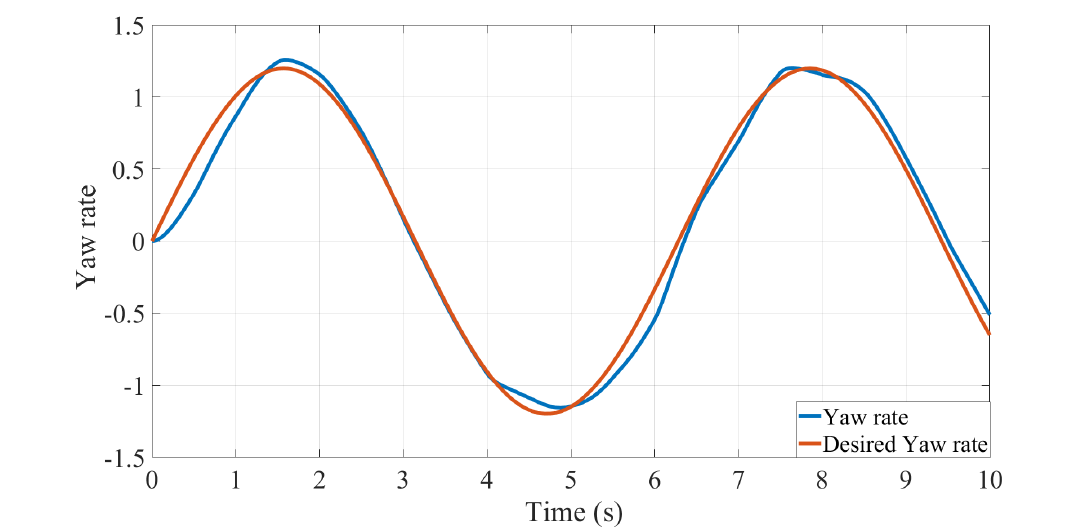
Figure 13. PI-controlled yaw rates with disturbance with sine wave